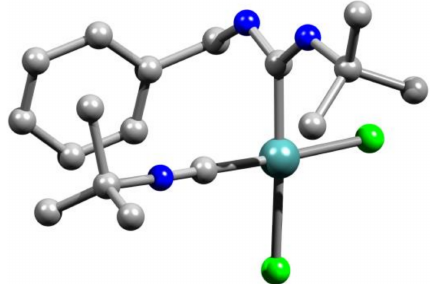
Figure 8. Stick-and-ball representation of the molecular structures of 7 in the crystal. Green, cyan, blue and grey spheres represent chlorine, palladium, nitrogen, and carbon atoms, respectively. H atoms were omitted for